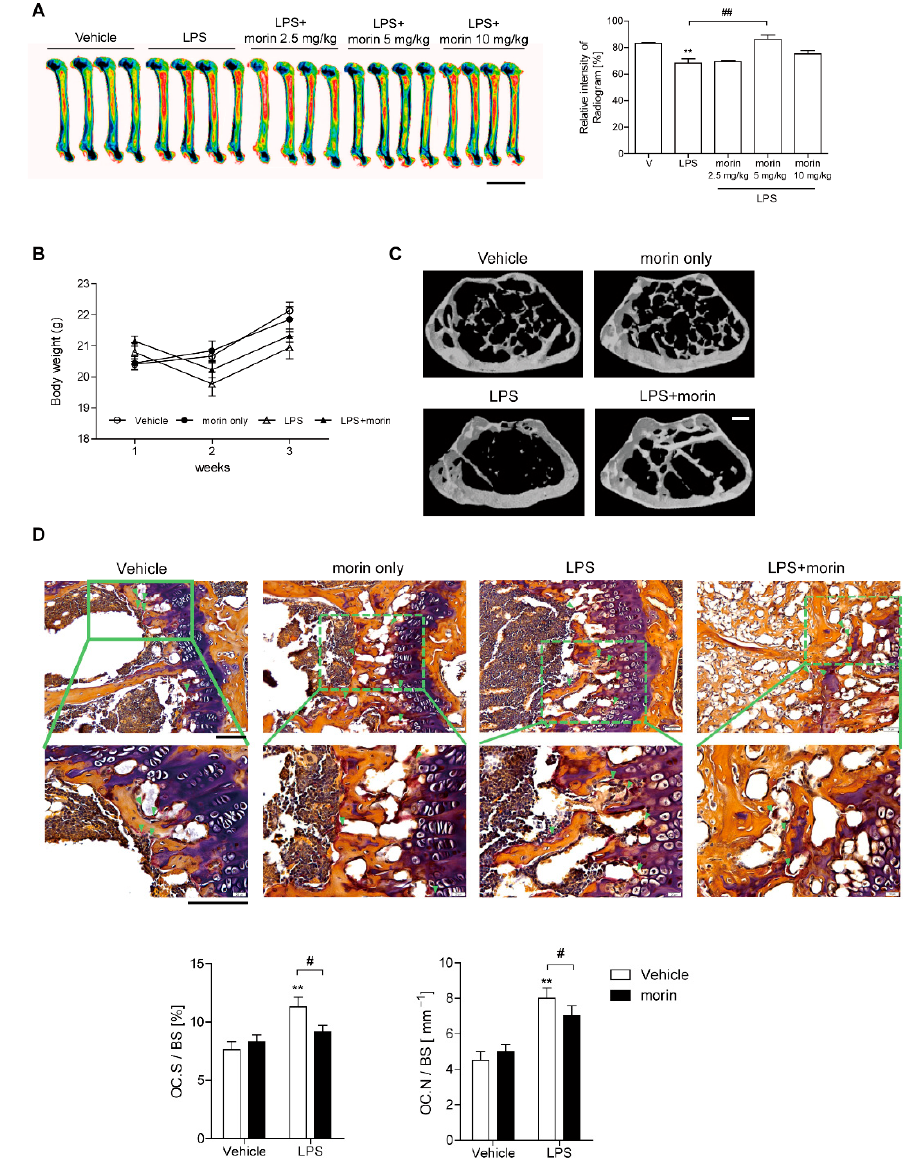
Figure 1. Protective effects of morin against LPS-induced bone loss in mice. ( A ) Representative images and relative intensities of X-ray radiograms of the distal femurs of mice treated with LPS (5 mg/kg/week) ( n = 4), or LPS + morin (2.5 mg/kg/day, n = 4; 5 mg/kg/day, n = 4; 10 mg/kg/day, n = 4), which were measured using the Image J software. Scale bar: 5 mm. Mice began to be injected at 10 weeks of age. ( B ) Body weight changes during the treatment period. ( C ) Representative µ CT images of distal femora 1.0 mm from the growth plate of mice treated with vehicle ( n = 4), LPS (5 mg/kg/week) ( n = 6), LPS + morin (5 mg/kg/day) ( n = 6), or morin only (5 mg/kg/day) ( n = 4). Scale bar: 2 mm. ( D ) Mouse femora were excised, cleaned, and decalcified in EDTA to analyze TRAP-positive OCs in vivo. Each of the four group’s histological sections were stained to indicate the presence of OCs (arrowhead) and calculate OC.S./BS (OC surface divided by total bone surface) and OC.N./BS (OC number divided by total bone surface). Image magnification: 200 × (upper); 400 × (lower). Scale bar: 100 µ m. ** p < 0.01, compared with vehicle-treated mice; # p < 0.05, ## p < 0.01 compared with LPS-treated mice. Differences between groups were analyzed by two-way ANOVA, followed by Bonferroni post hoc tests to compare the effect of LPS (OC.S./BS, p < 0.05; OC.N./BS, p < 0.001), the effect of morin (OC.S./BS and OC.N./BS, not significant), and their interaction (OC.S./BS and OC.N./BS, not